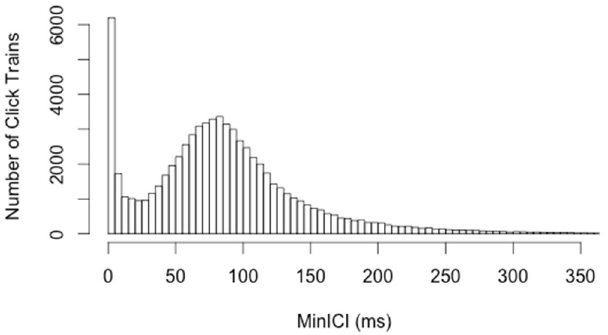
Figure 2. Histogram of minimum inter-click intervals (minICIs) for bottlenose dolphin click trains in the Shannon Estuary.